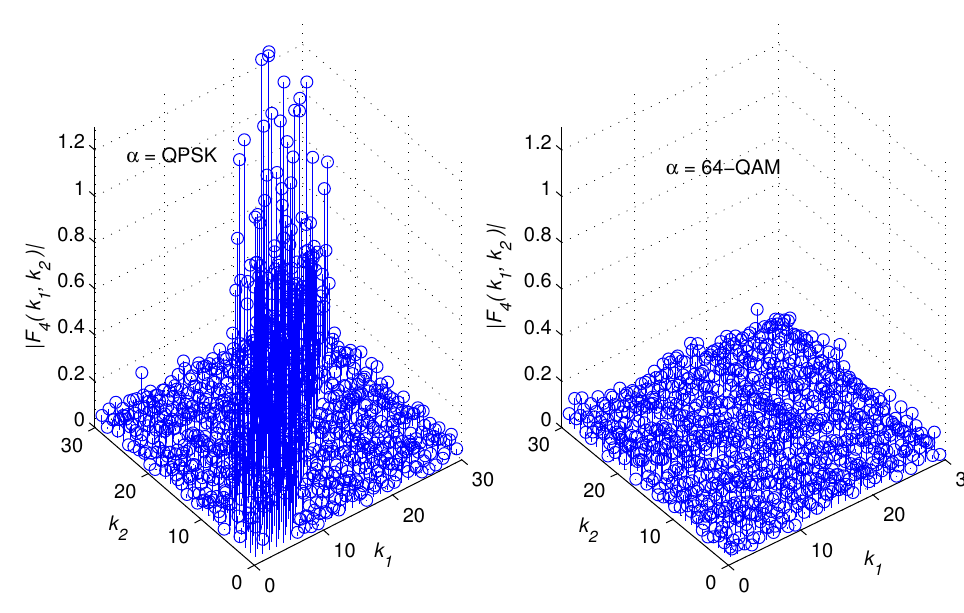
Figure 5. | F 4 ( k 1 , k 2 ) | for QPSK and 64 − QAM modulations.